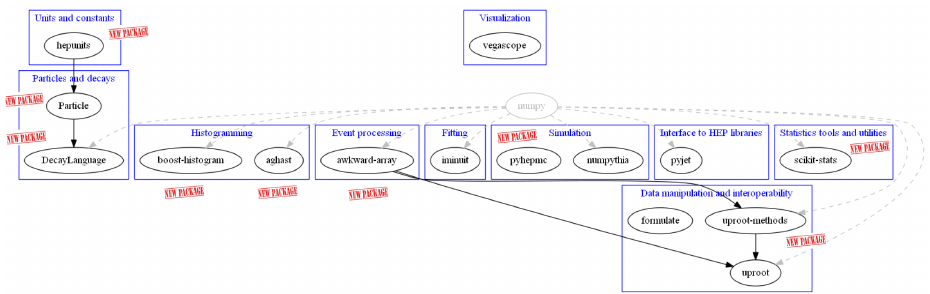
Figure 2. Overview of (most of) the packages making the Scikit-HEP toolset. For a sense of evolution all packages whose first release came out after the CHEP 2018 conference are marked as "new package". All GitHub repositories can be found at the location https: // github.com /